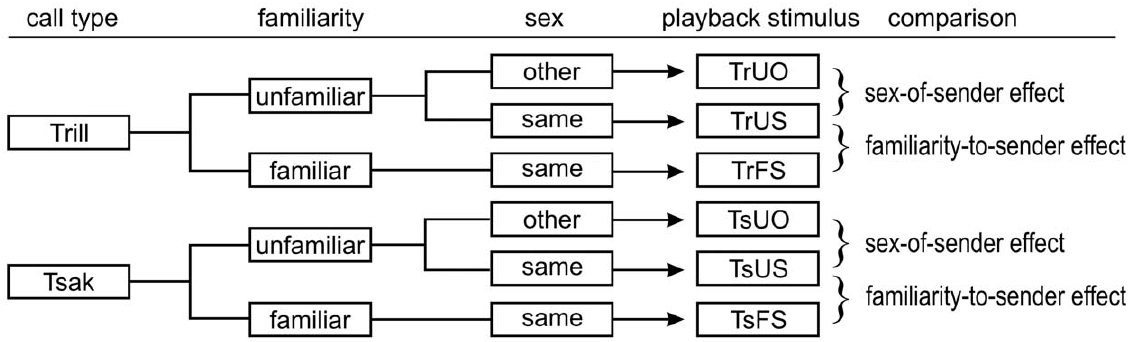
Figure 1. Schedule of the playback stimuli. This schedule shows how the playback stimuli differ from each other in call type, familiarity and sex, and how they are compared to test the effects of familiarity-to-sender and sex-of-sender.